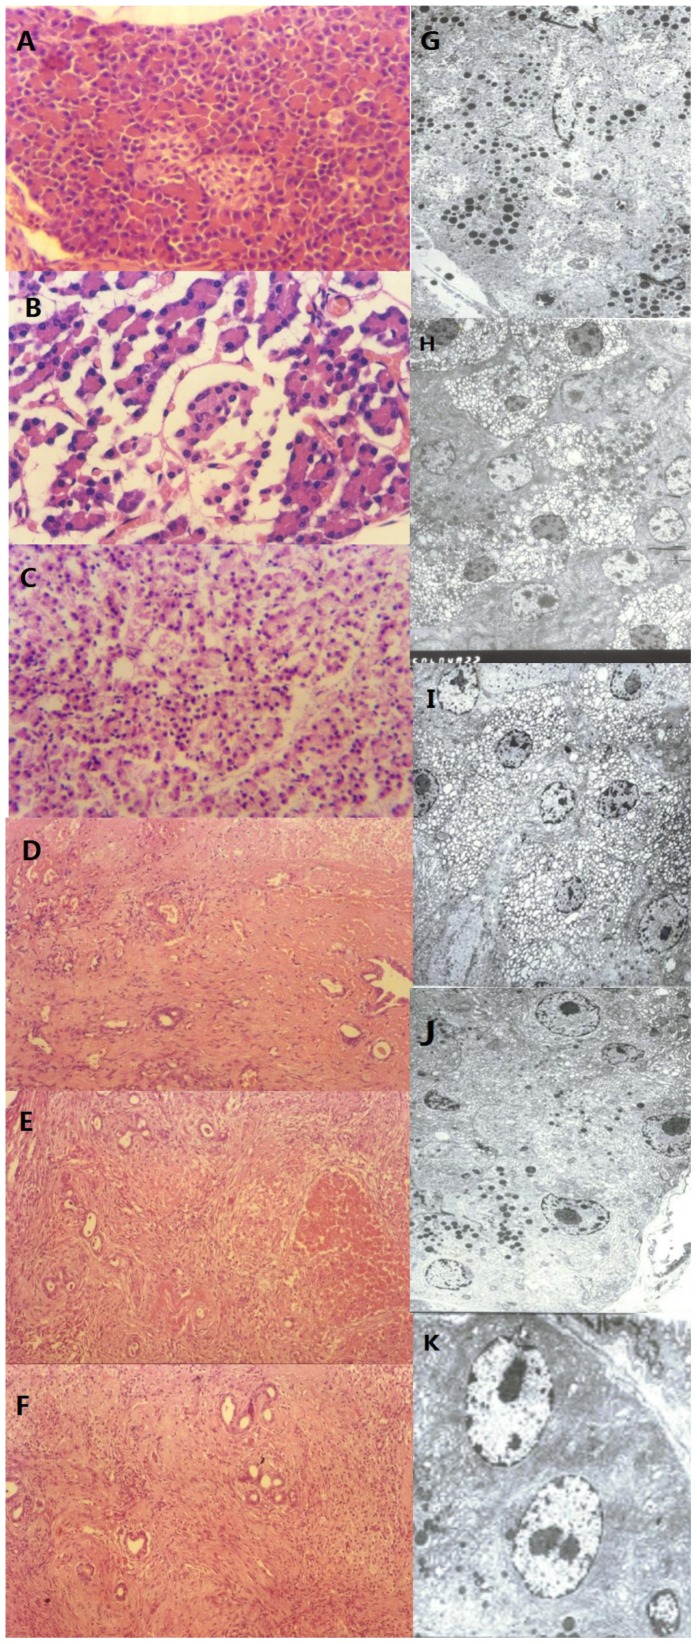
Optical and electron microscope performance of insonified and non-insonified sites after Focused Ultrasound: A (H.E×200), Immediately after FUS, the noninsonified site, islets and exocrine cells were normal in morphology and structure; B(H.E×400) and G(×4000), immediately after Focused Ultrasound, cells in the insonified sites started irreversible necrosis process;C (H.E×200) and H(×5000), 3 days after treatment, the acinar structures were “destroyed,” karyolysis, nuclear fragmentation were observed. D (H.E×100) and I (×3500), 7 days after operation, repair process started and newborn pancreatic ducts formed; E (H.E×100) and J(×4000), 14days after operation, insonified site was replaced by fibrous connective tissue and abundant newborn pancreatic ducts formed; F(H.E×100) and K(×4000), 21days after operation, the necrosis site was replaced by fibrous tissue, pancreatic duct hyperplasia was clearly observed.